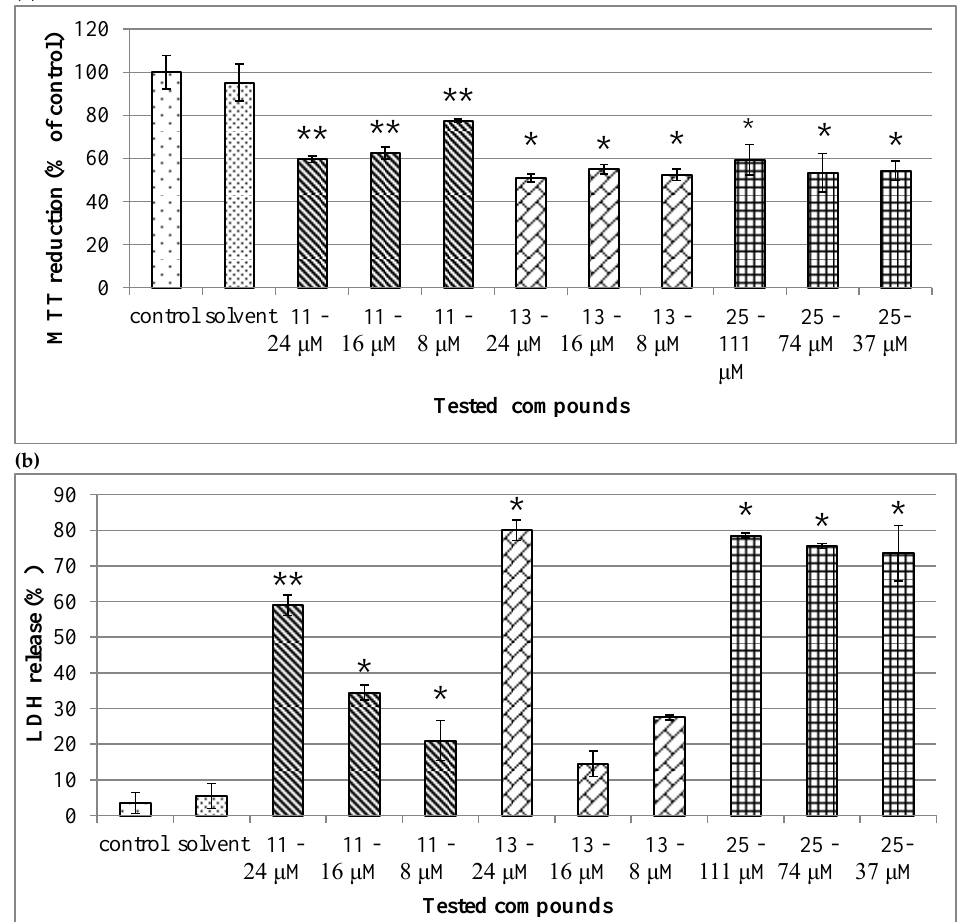
Figure 2. Cell viability assessed by MTT mitochondrial reduction ( a ), and LDH release ( b ) as a marker of cell death in HaCaT cells treated for 24 h with compounds 11 , 13 and 25 . Data are expressed as means ± SD from three independent experiments performed in triplicate. Statistical significance: * p < 0.01 and ** p < 0.001 refer to the control (untreated) cells.